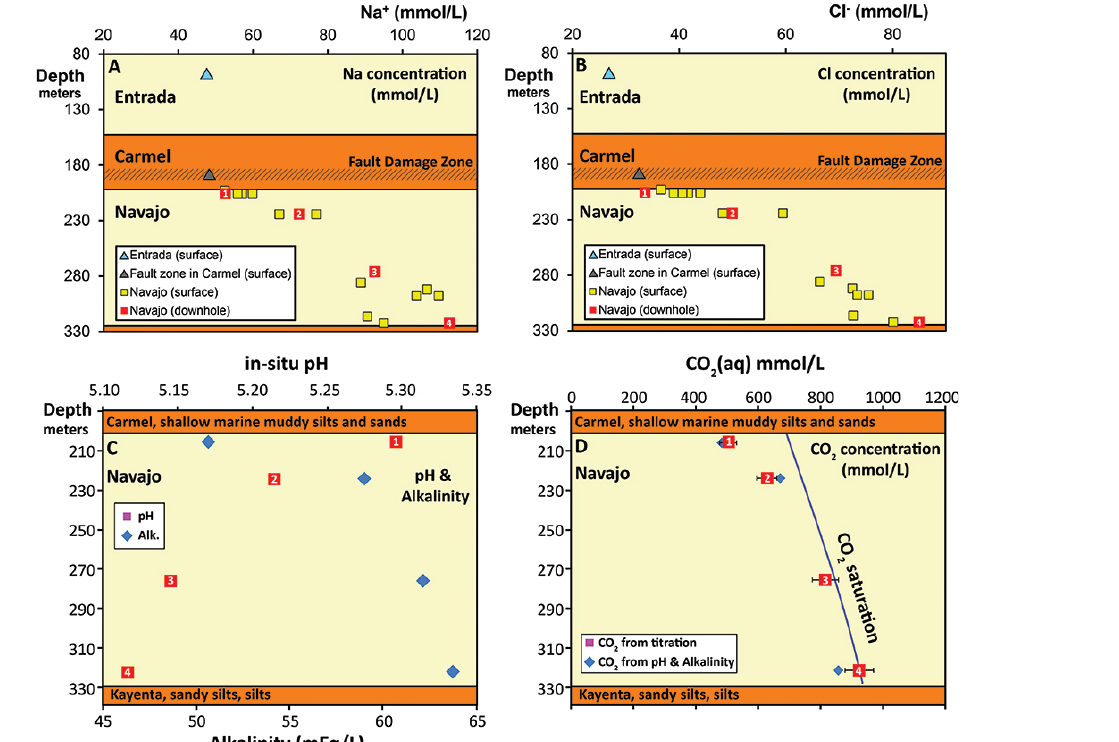
Figure 7. Preliminary results from the surface and downhole fluid sampling campaign. (A–B) Na + and Cl − concentrations in downhole and surface sampled fluids. The geochemical profiles illustrate inflow of CO 2 -charged brine at base of the formation and mixing between brine flowing through the faults and meteoric fluid flowing horizontally into the fault zone. (C) In situ pH measured on pressurized samples and alkalinity determined by Gran titration in the field. (D) Dissolved CO 2 concentrations measured directly on titrated samples and recalculated from measured pH and alkalinity. Also shown is the theoretical CO 2 solubility curved calculated for a hydrostatic pressure gradient, local geothermal gradient and measured salinity profile using the equations of Duan et al.